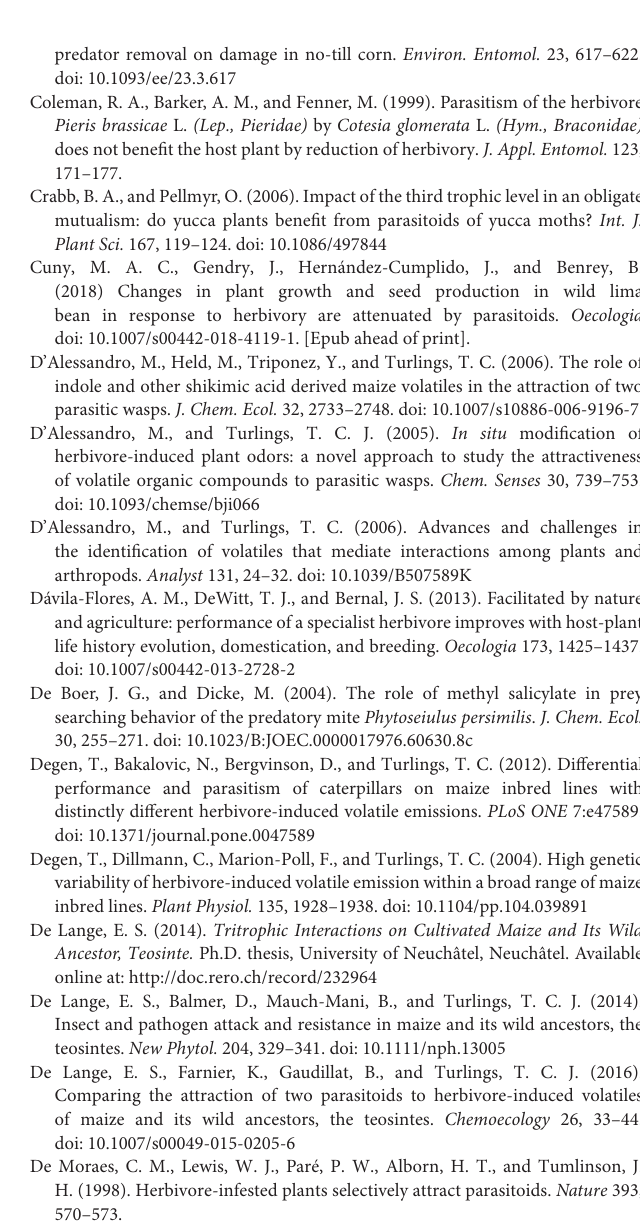
Campoletis sonorensis parasitoid wasps ( + W, ++ W, + + + W), for all three teosinte varieties, in all three replicates of the experiments. R 2 = 0.53, P < 0.001. The dashed line represents a linear trendline. Figure S9 | Chromatograms of volatiles collected from herbivore-damaged teosinte plants. (A) Teosinte population Tzitzio ( Zea mays ssp. parviglumis ). (B) Teosinte population Hidalgo ( Z. mays ssp. mexicana ). (C) Teosinte population Cuitzeo ( Z. mays ssp. mexicana ). Volatile emissions were measured in tents that were infested with Spodoptera frugiperda larvae in the absence of parasitoid wasps (SF). Collections started 1 day after larval infestations and were repeated on 4, 5, or 6 consecutive days, using different plants. The labeled compounds are among the most abundant volatiles: (1) heptanal; (2) α -pinene; (3) 2-methyl-2-hepten-6-one; (4) ( Z )-3-hexenyl acetate; (5) hexyl acetate ∗ ; (6) limonene; (7) ( Z )- β -ocimene; (8) linalool; (9) (3 E )-4,8-dimethyl-1,3,7-nonatriene; (10) 2-ethylhexyl acetate ∗ ; (11) phenylmethyl acetate ∗ ; (12) 2-phenylethyl acetate;